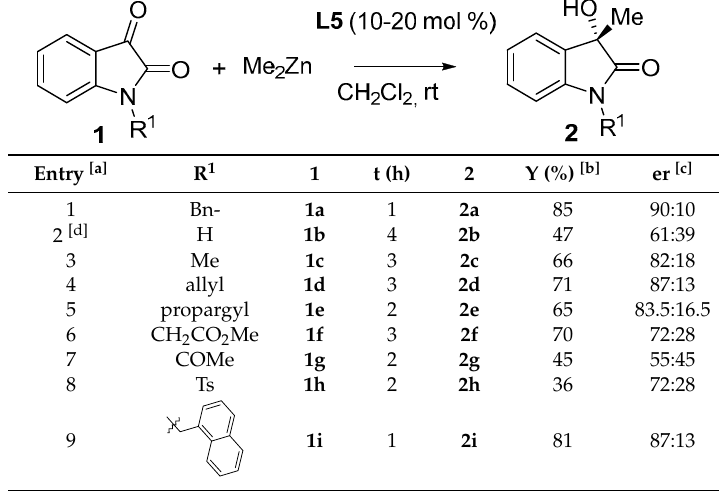
Table 3. Evaluation of the protecting group of the isatin.